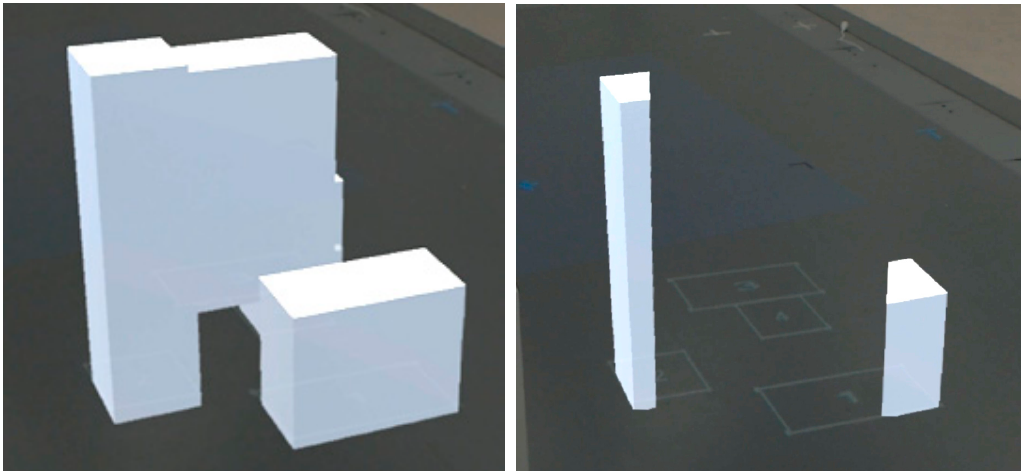
Figure 11. Four opaque cubes ( left ), shown with a vertical AR mask in the middle of the FOV ( right ) showing the real world (all black is transparent on the HMD). SAR projections are visible on the ground in the middle of the right image. Image levels have been adjusted to enhance contrast.